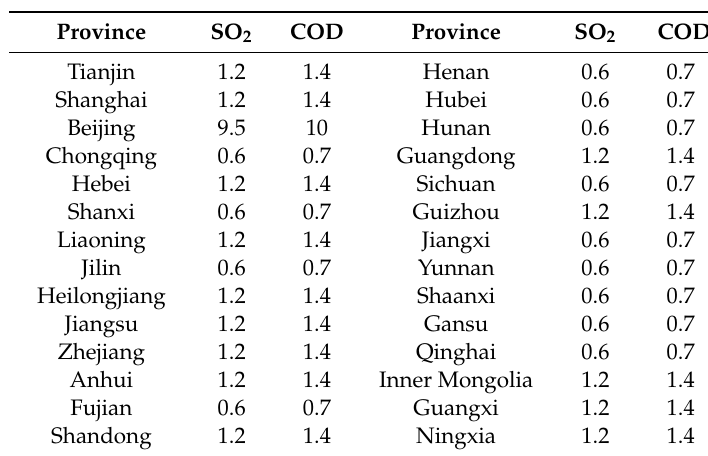
Table 1. The sewage charge rates for SO 2 and Chemical Oxygen Demand (COD) in 28 provinces in 2014 in China (yuan / per pollution